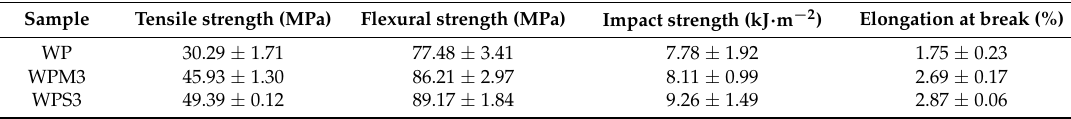
Table 3. Mechanical properties of wood flour/PLA composites comprising compatibilizer with different grafting degrees.